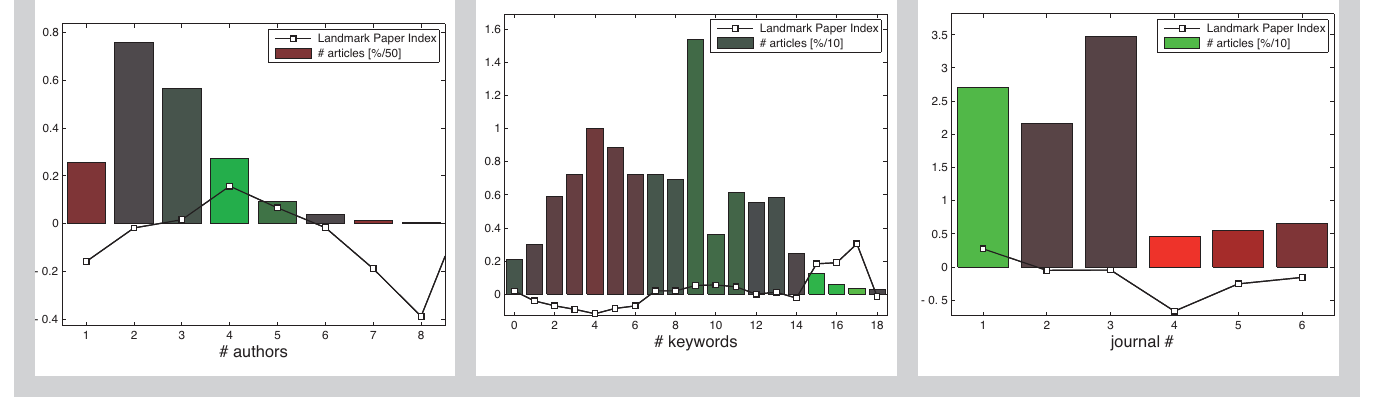
Figure 7 (left): Number of authors and their correlation with the LPI. Figure 8 (middle): Number of keywords pub- lished with articles versus LPI. Figure 9: LPI evaluated for all articles published between 2000 and 2005, shown are mean values for six h -journals in undisclosed